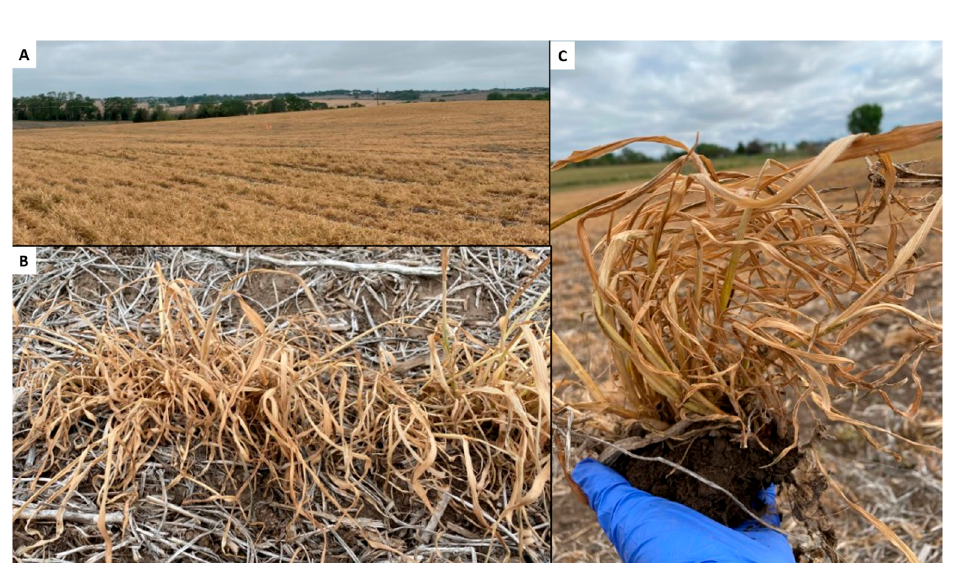
Figure A1. Cover crop status on a late cover-crop termination application at site 5 ( A ), site 4 ( B ), and site 7 ( C ).